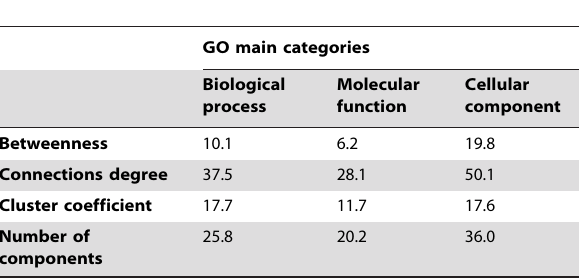
Table 2. Percentage of significant network parameters (p , 0.05) in the different GO module